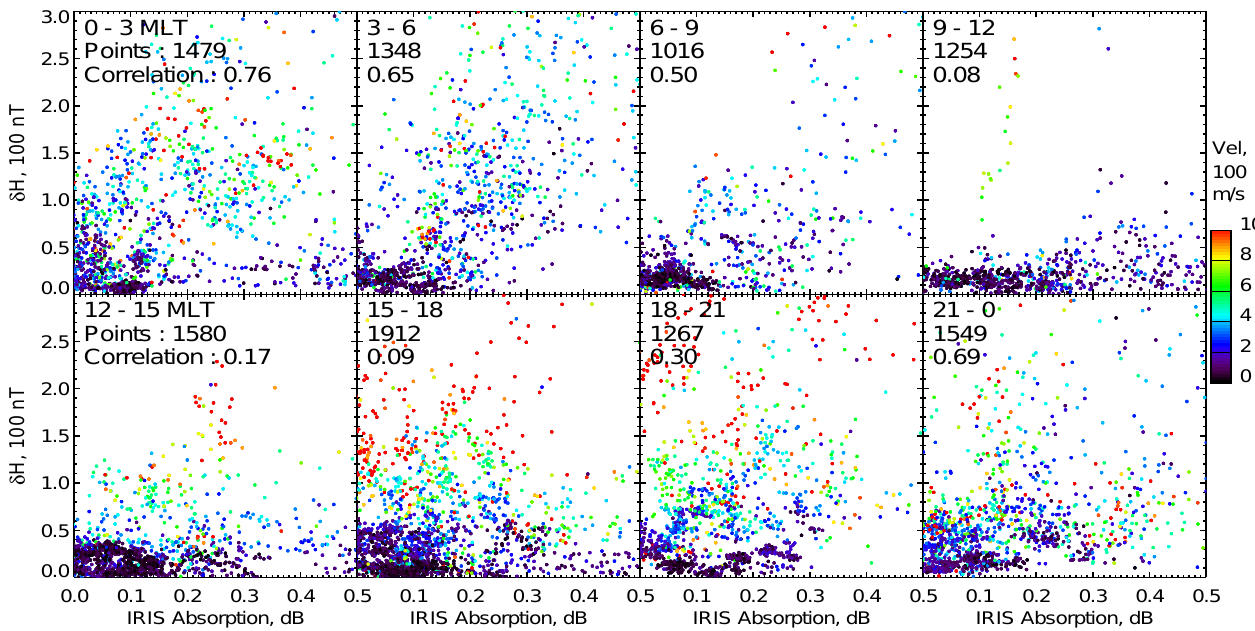
Fig. 4. The same as Fig. 3 except magnetic perturbation and absorption are compared and colour-coded in velocity.